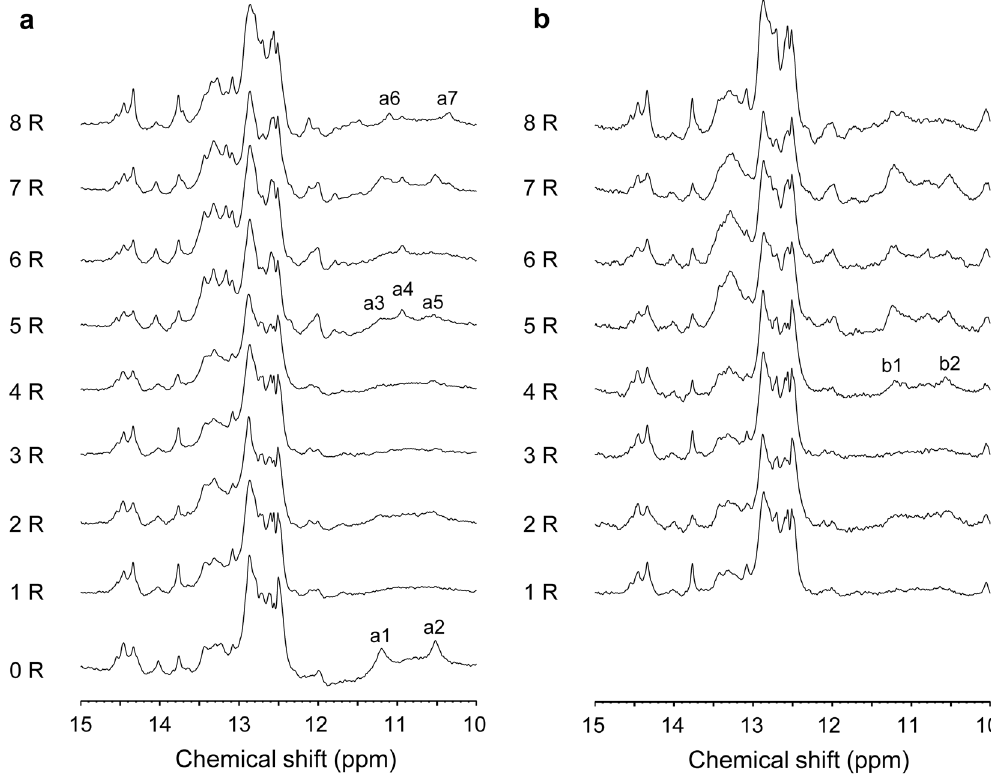
Figure 2. 1D imino proton spectra of RNA pools in the absence and presence of RD. 1D imino proton spectra of 0–8R RNA pools of SELEX in the absence ( a ) and presence ( b ) of